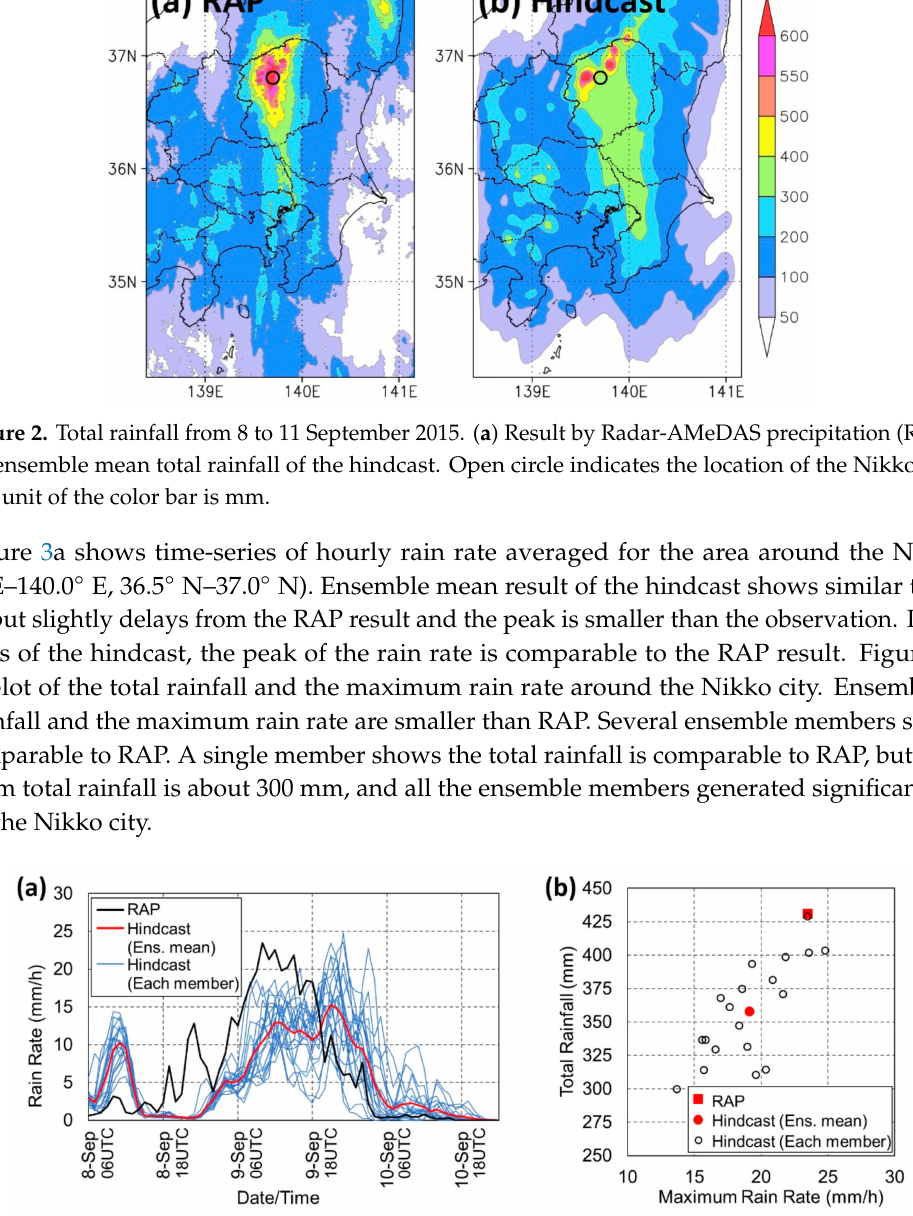
Figure 3. ( a ) Time-series of hourly rain rate averaged for the area around the Nikko city; ( b ) scatter plot of the maximum rain rate and total rainfall averaged for the area around the Nikko